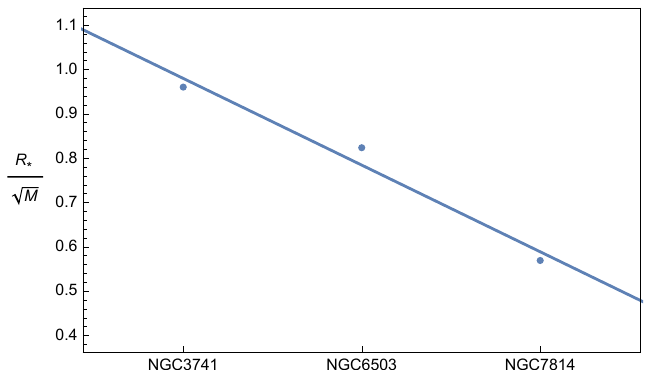
Figure 7 . Ratio (4.56) (in units m kg − 1 / 2 ) for the galaxies NGC3741, NGC6503 and NGC7814 in the case α = 4 / 3